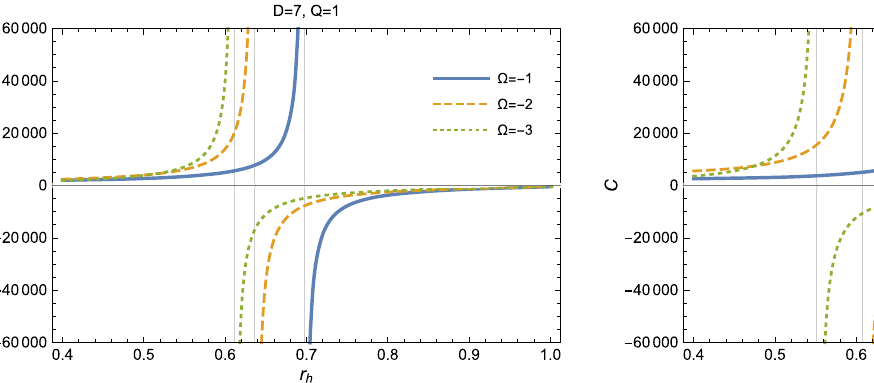
Q ≡ − ( D − 1 ) q ω q and (cid:5) ≡ ( D − 1 )ω q , respectively. The phase tran- sition point r h = r c , where the heat capacity diverges increases as the |